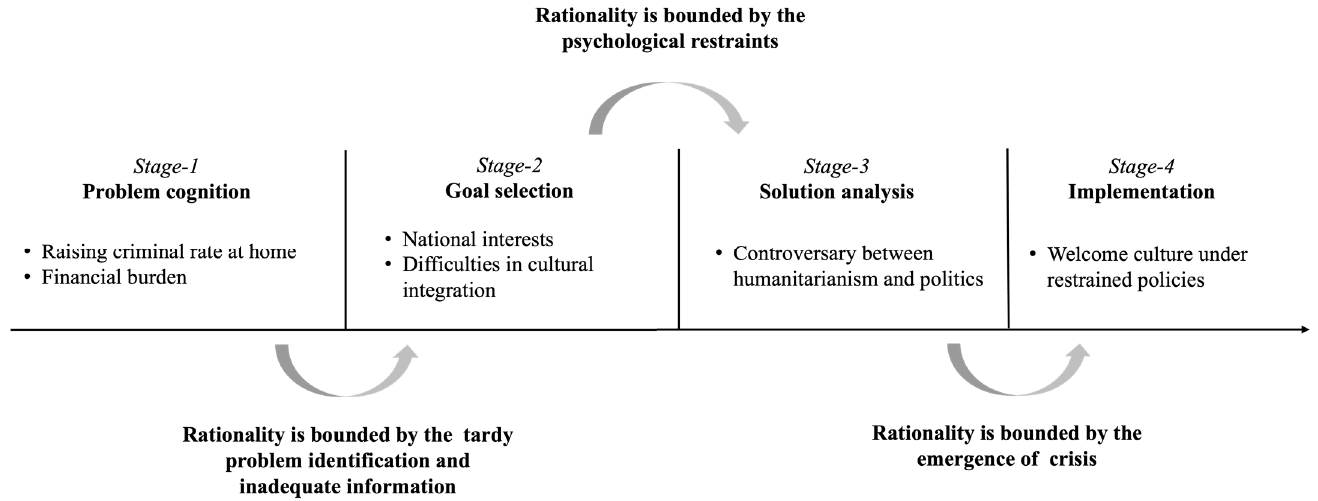
Figure 5. Diagram of the second shift in the refugee policy of Germany. Flow chart made by au-